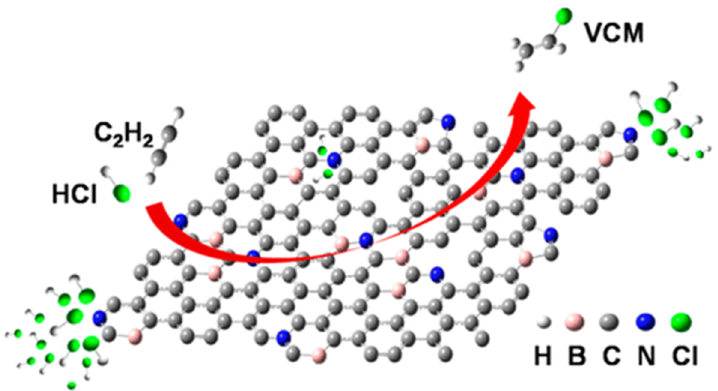
Figure 21. B,N-graphene catalyst for acetylene hydrochlorination [123].